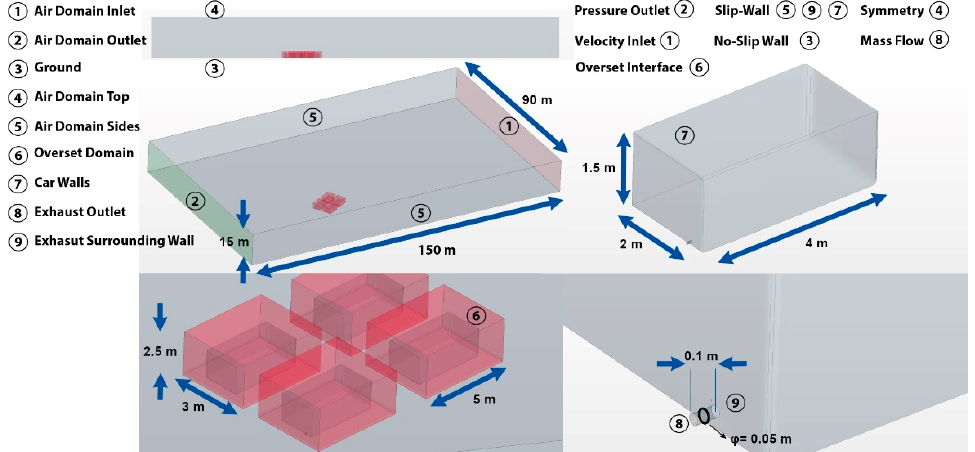
Figure 2. Geometry of the computational domain, boundary conditions and relevant dimensions. The top left image shows the wind angle, which is calculated according to a clockwise rotation from the direction of vehicles’ travel. Table 1. Details of the different case studies.